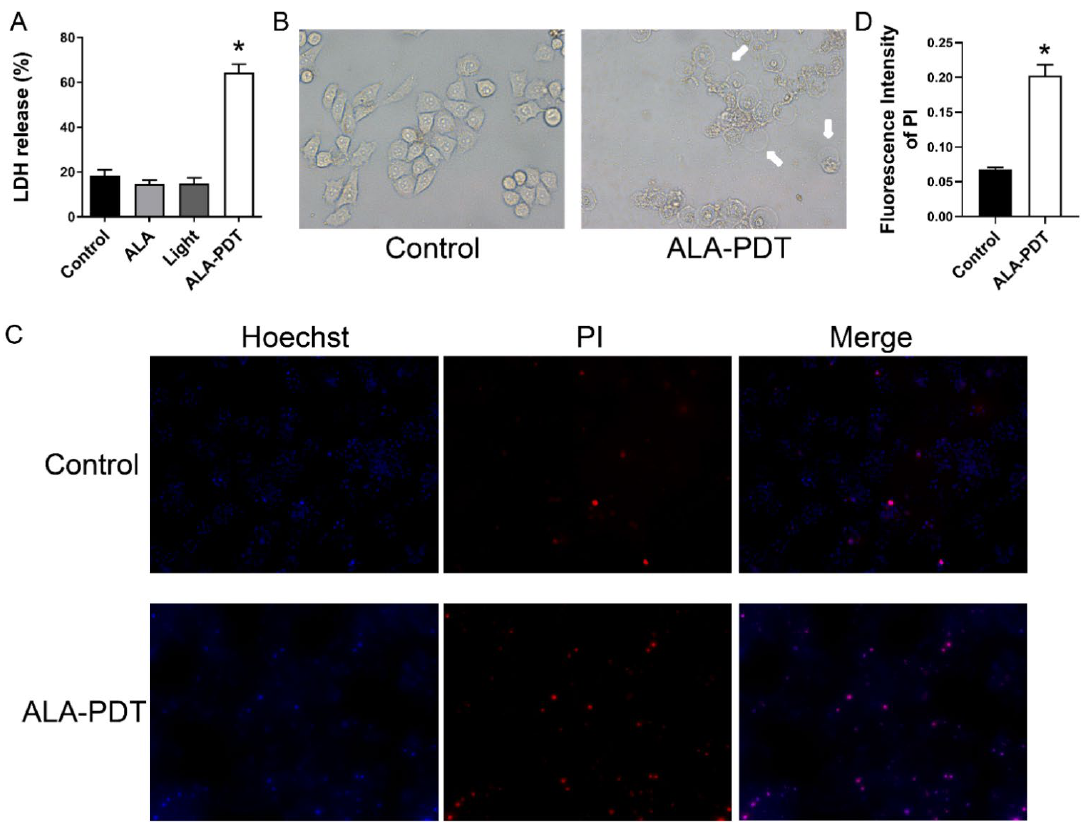
Figure 4. ALA-PDT induces the destruction of cell membrane and the morphologic change of HeLa cells. ( A ) ALA-PDT promoted LDH release in HeLa cells. * p < 0.05 compared with the control group. ( B ) The morphologic change of HeLa cells in bright field (400×). White arrowheads indicated the large bubbles emerging from the cell membrane. ( C ) Hoechst/ PI staining assay in HeLa cells after ALA-PDT treatment (100×). ( D ) Statistical analysis of the fluorescence intensity of PI-positive cells. * p < 0.05 compared with the control group.